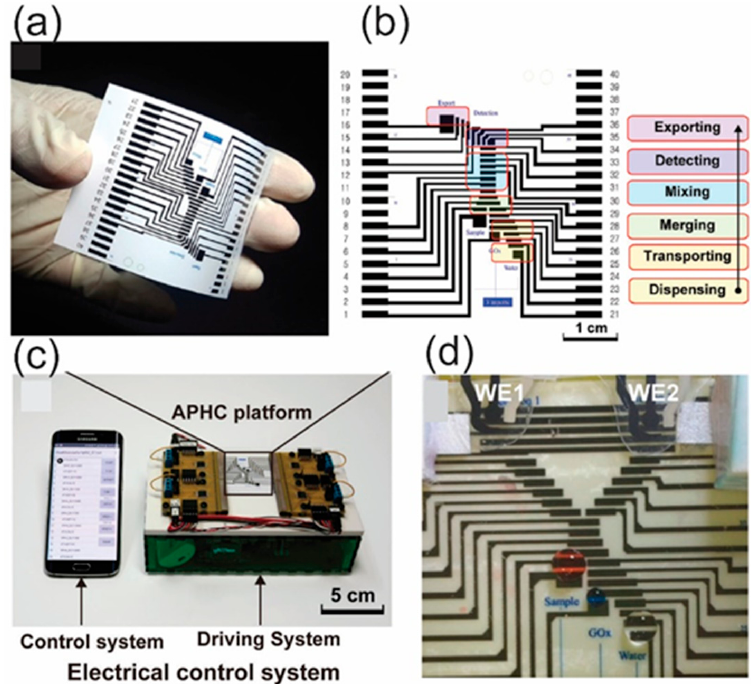
Figure 4. ( a ) A photograph of a p-DMF device, ( b ) schematic illustration fluid handling on the device, ( c ) a controlling system for operation of the p-DMF device, and ( d ) operation of the device to